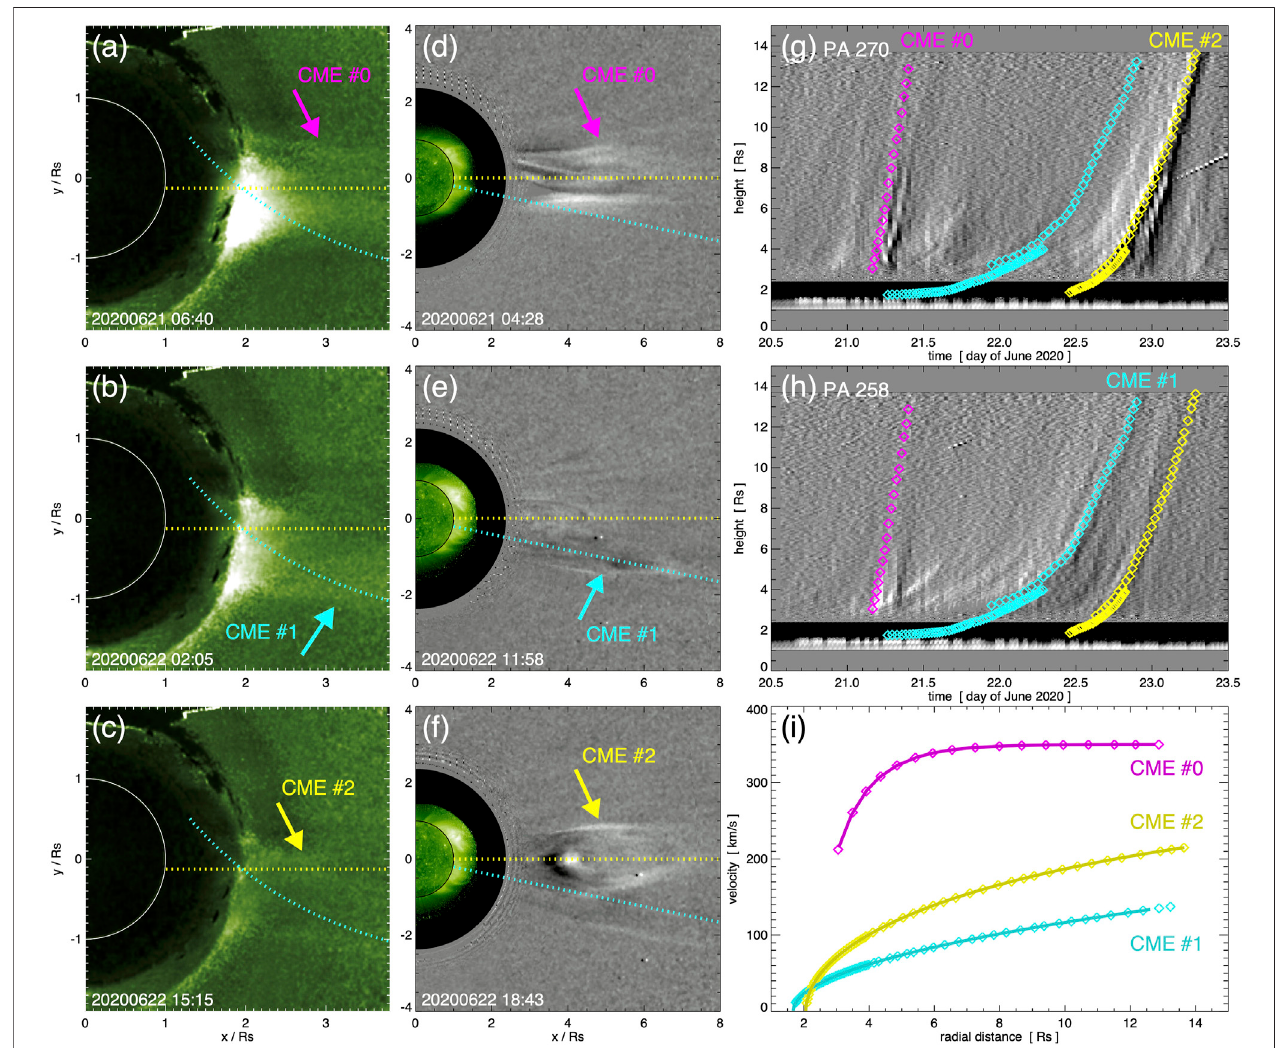
FIGURE 4 | Coronal dynamics for each of the three sequential CMEs over the 2020 June 21 – 22 sequential/sympathetic eruption period. (A – C) STA/COR1 signaturesofCMEs#0,#1,and#2,respectively.TheprocessedCOR1movieisavailableas SupplementaryVideoS2 inthesupplementarymaterial.Thecyan(yellow) dotted line shows the sampling track of CME #1 ’ s (CME #2 ’ s) COR1 height-time points. (D – F) STA/COR2 running-difference signatures of each eruption with PAs 258 (cyan) and 270 (yellow) used in the COR2 height-time points for CME #1 and CMEs #0 and #2, respectively. The running difference COR2 movie is included as SupplementaryVideoS3 inthesupplementarymaterial. (G) STA/COR2J-mapatPA270withtheheight-timepointsover-plotted. (H) STA/COR2J-mapatPA258. (I) Radial evolution of the CME velocity from fi ts to the Sheeley et al. (1999) formulation for the height-time pro fi les (CME #0 – magenta, #1 – cyan, #2 – yellow).